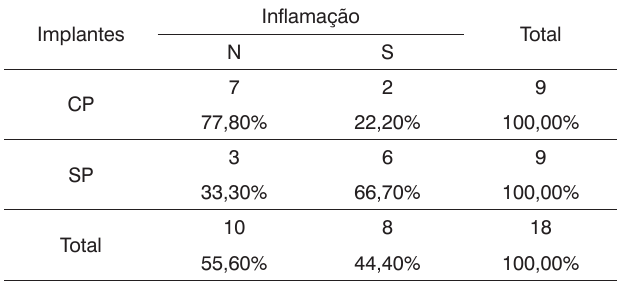
Tabela 4. Padrão Inflamatório dos seios maxilares com e sem